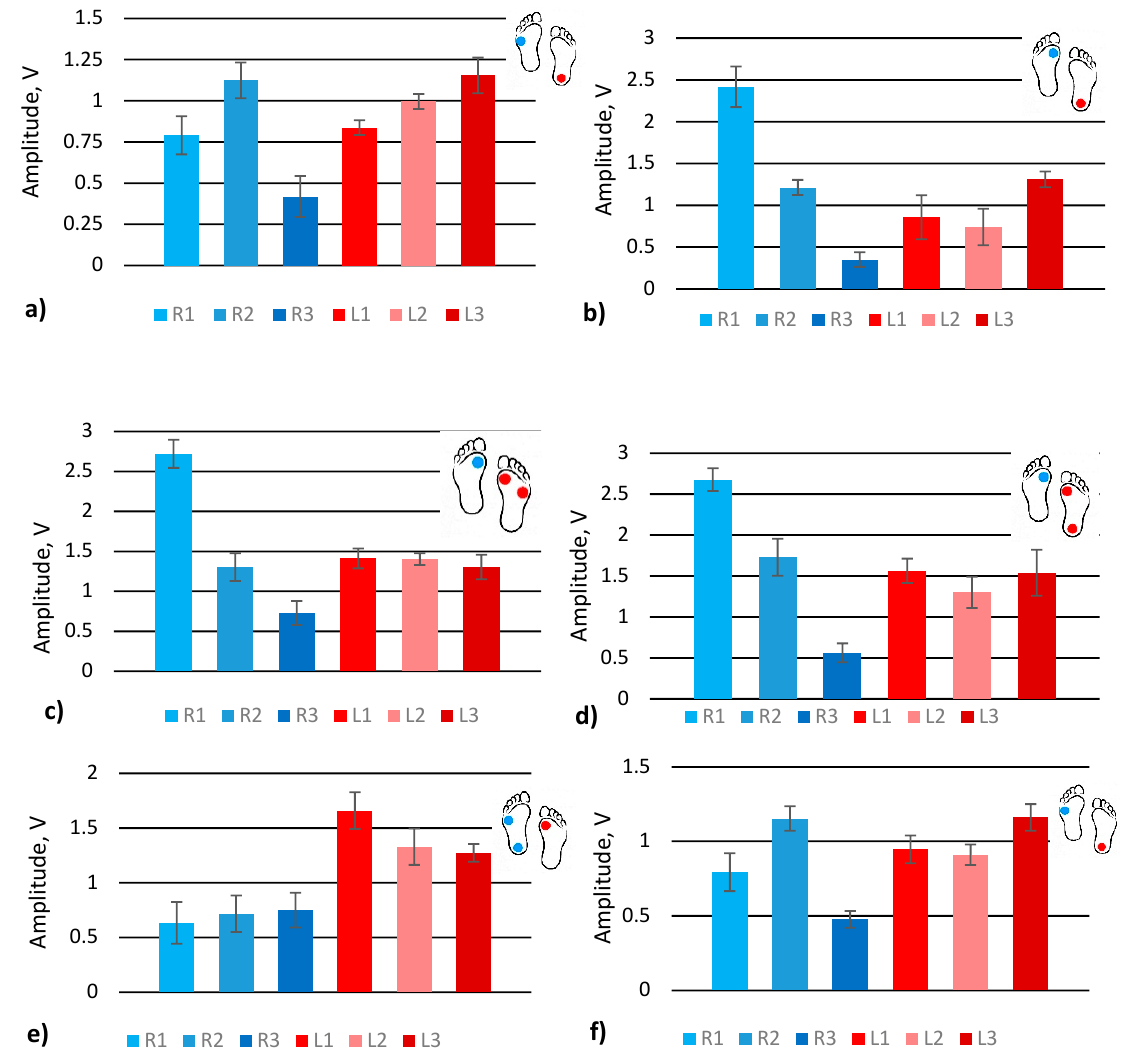
Figure 4. Analysis of signal amplitudes obtained from simulating various gates: ( a ) turnaround; ( b ) scrolling; ( c ) upstairs; ( d ) downstairs; ( e ) upstairs one by one; ( f ) walk with left straight leg.